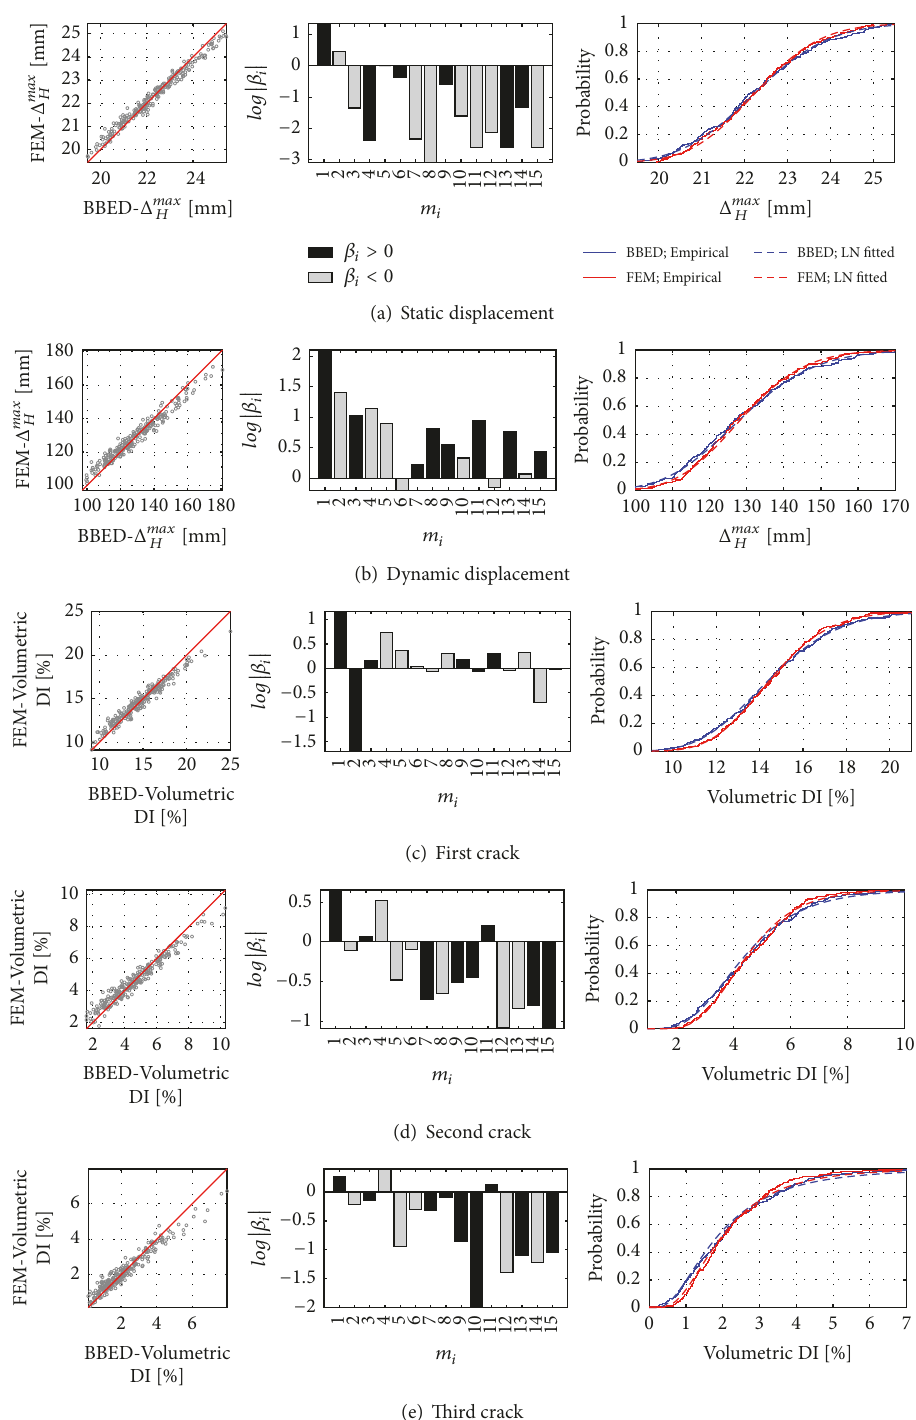
Figure 12: Validation of the predicted response surface using LHS